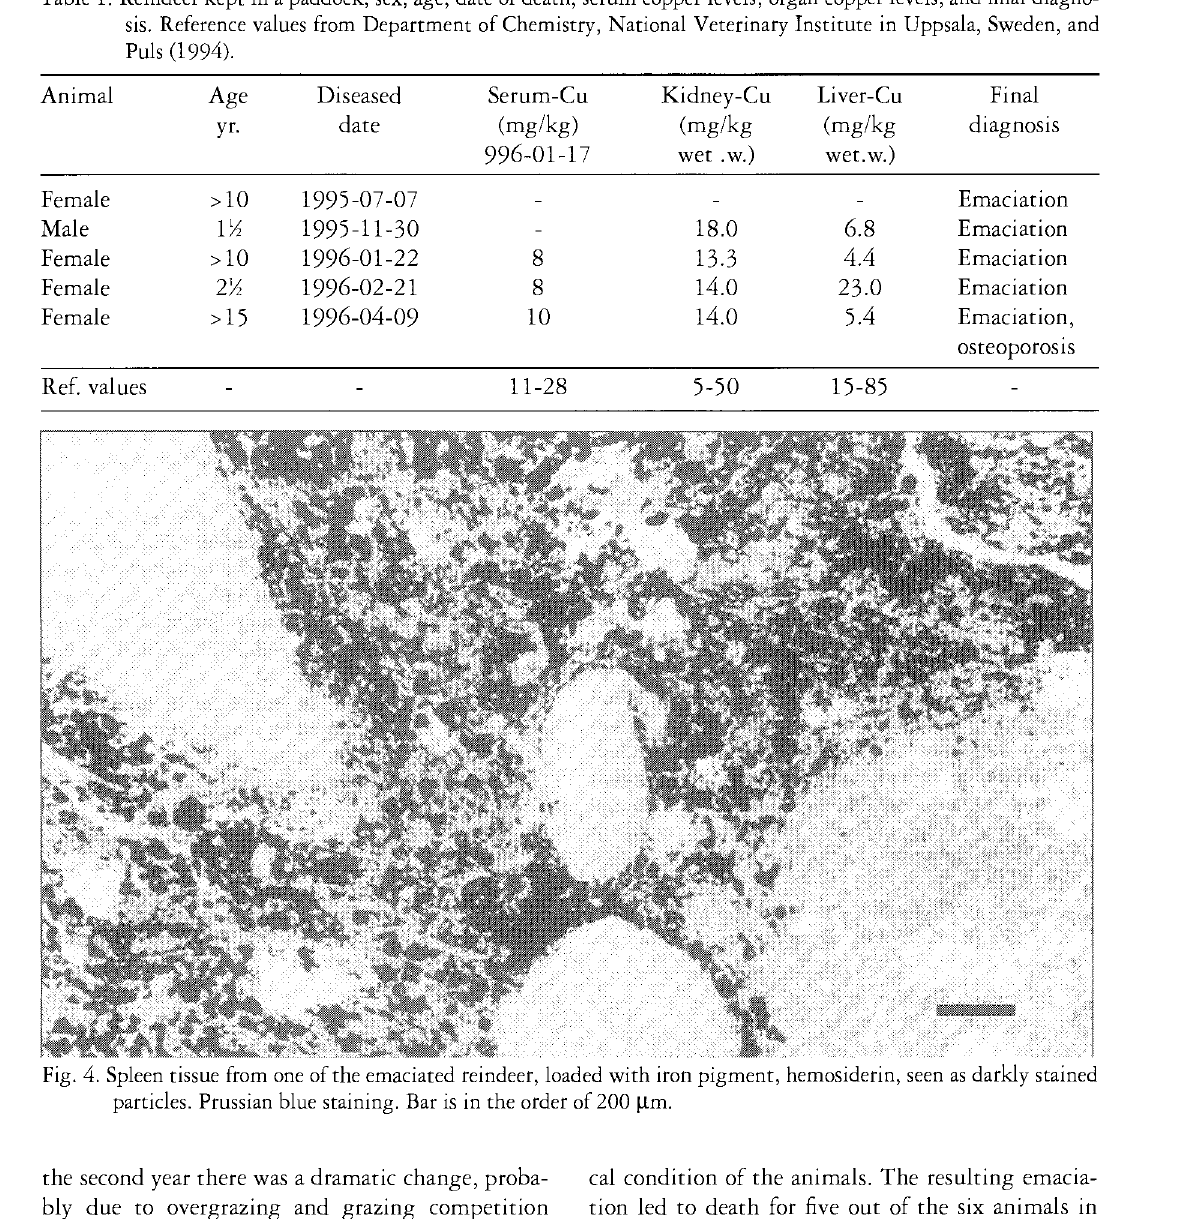
Fig. 4. Spleen tissue from one of the emaciated reindeer, loaded with iron pigment, hemosiderin, seen as darkly stained particles. Prussian blue staining. Bar is in the order of 200